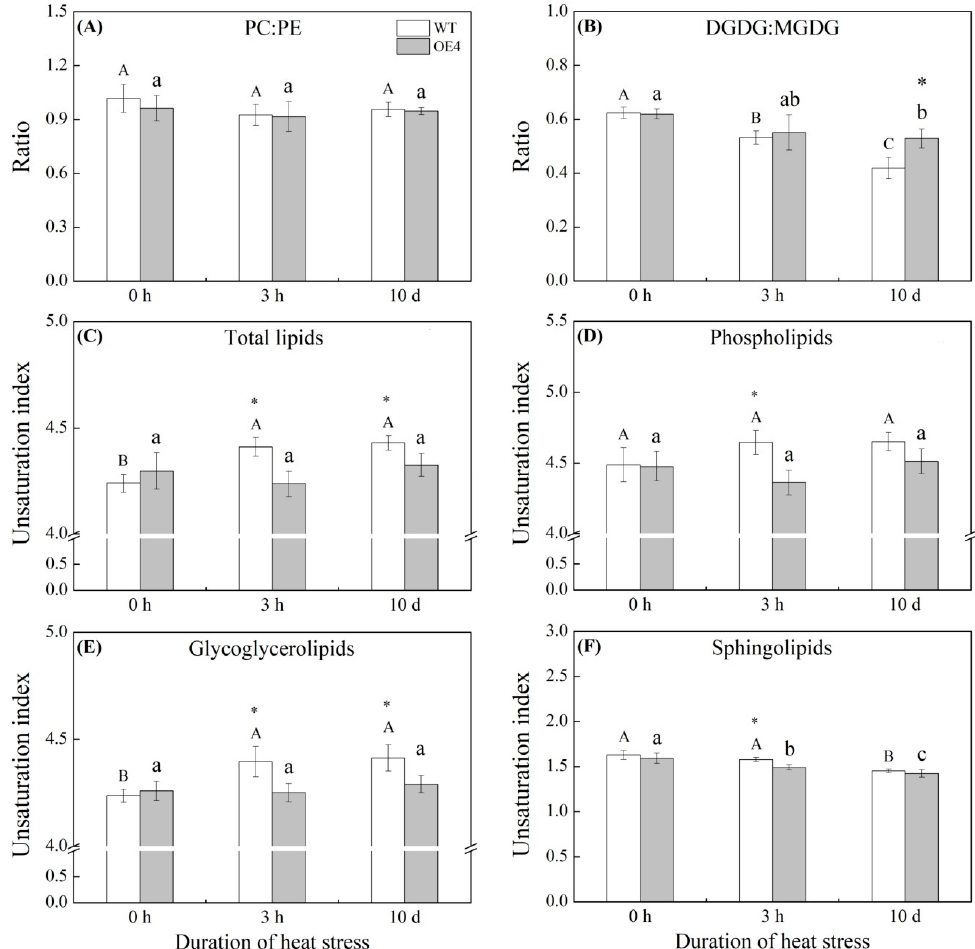
Figure 8. Changes in ( A ) the ratio of PC:PE, ( B ) the ratio of DGDG:MGDG, ( C ) the unsaturation index of total lipids, ( D ) the unsaturation index of phospholipids, ( E ) the unsaturation index of glycoglycerolipids, and ( F ) the unsaturation index of sphingolipids in leaves of wild type (WT) and transgenic Arabidopsis thaliana overexpressing the TrSAMS involved in spermidine biosynthesis during heat stress. Different letters above column indicate significant differences ( p ≤ 0.05) in a particular material (WT or OE4) from 0 h to 10 d. The asterisk “*” indicates significant differences ( p ≤ 0.05) between WT and OE4 at one particular time point (0 h, 3 h, or 10 d). 2.6. Key Genes Involved in PI and PA Metabolic Pathways Regulated by Spermidine in Ara- bidopsis thaliana under Heat Stress Heat stress induced significant increases in transcript levels of phosphatidylinositol 4-kinase alpha ( AtPI4K-alpha ), phosphatidylinositol phosphate 5-kinase 1 ( AtPIP5K1 ), phospho-